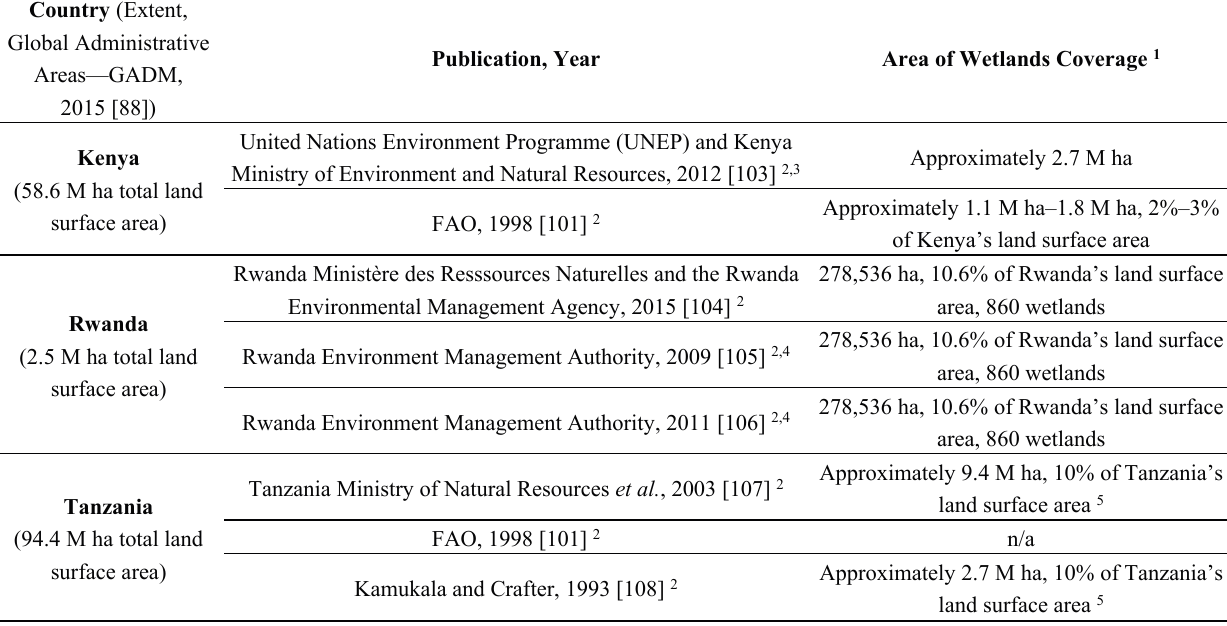
Table 5. Compilation of national wetland maps for the project countries. Shaded rows of data indicate the datasets illustrated in Figure 4. Wetlands areas (shown in brackets) have been calculated by the authors; all other estimates were sourced from the